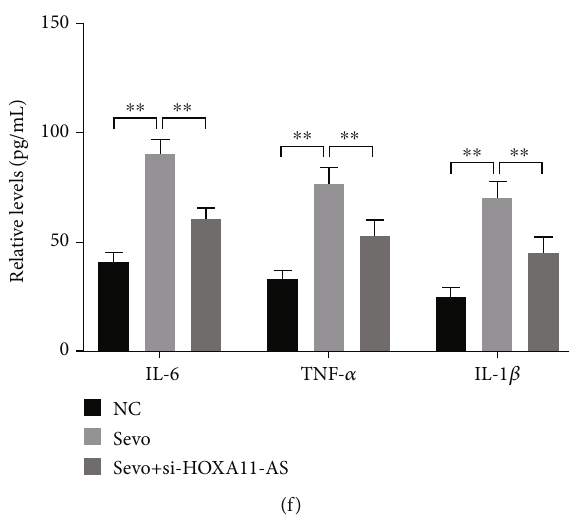
Figure 1: Inhibition of HOXA11-AS alleviates the cognitive impairment caused by sevo fl urane in rats. After 3 days of anesthesia, the hippocampal tissue was taken for the following experiments: (a) RT-qPCR detection of HOXA11-AS expression in rat hippocampus. (b, c): MWM test to detect escape latency and the number of platform crossings. (d) HE staining to detect rat hippocampal tissue pathological phenomena. (e) TUNEL staining to detect rat hippocampal tissue nerves apoptosis. (f): ELISA detects in fl ammatory factor (IL-6, TNF- α , and IL-1 β ) levels in rat hippocampus. ∗∗ P < 0 : 01